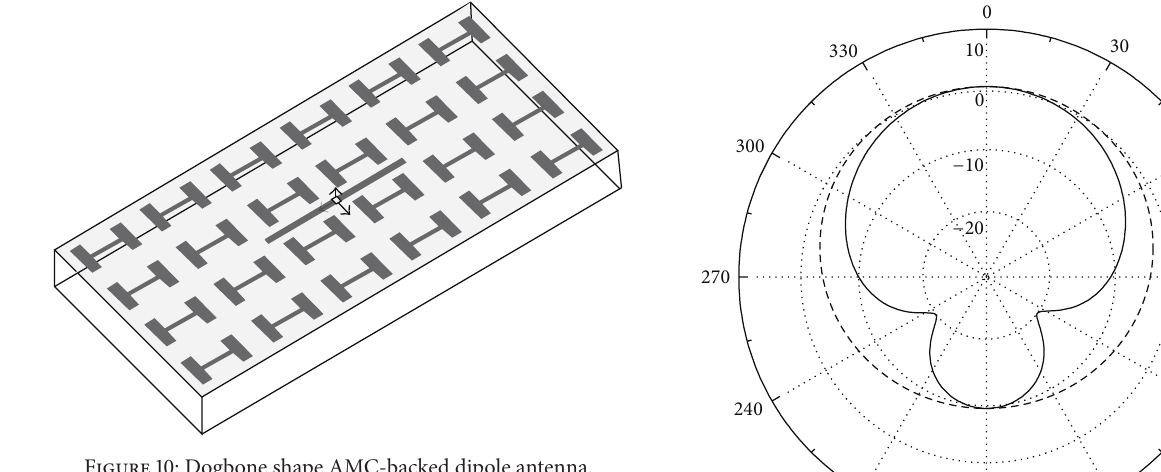
Figure 10: Dogbone shape AMC-backed dipole antenna.